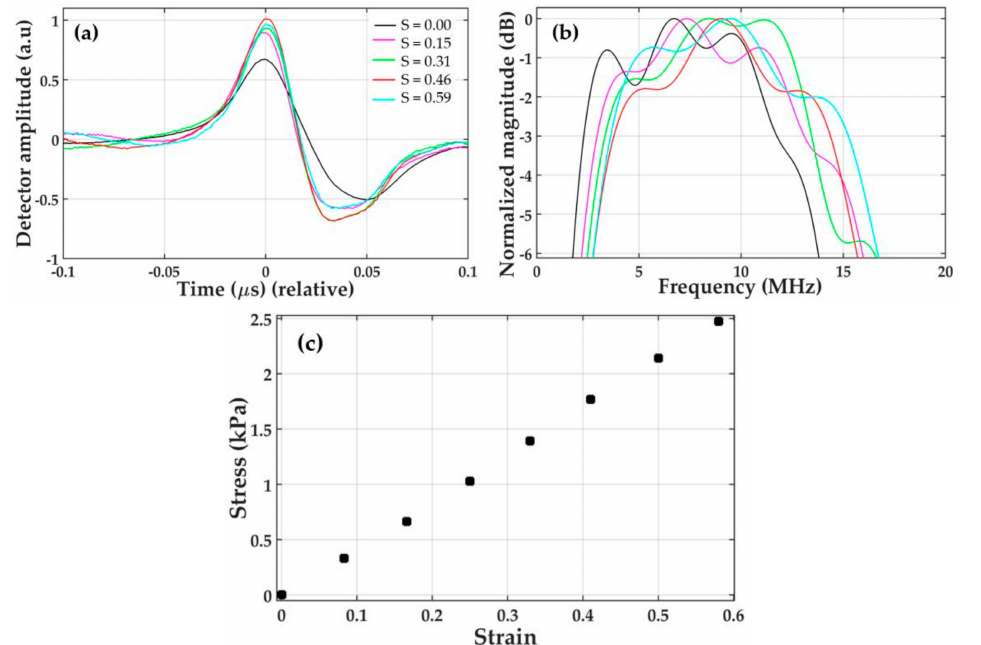
Figure 6. ( a ) Time-domain waveform generated by p40d transmitter under di ff erent strain values; ( b ) Frequency spectra measured from the time-domain waveforms in ( a ). ( c ) Stress-strain curve for p40d transmitter within its elastic